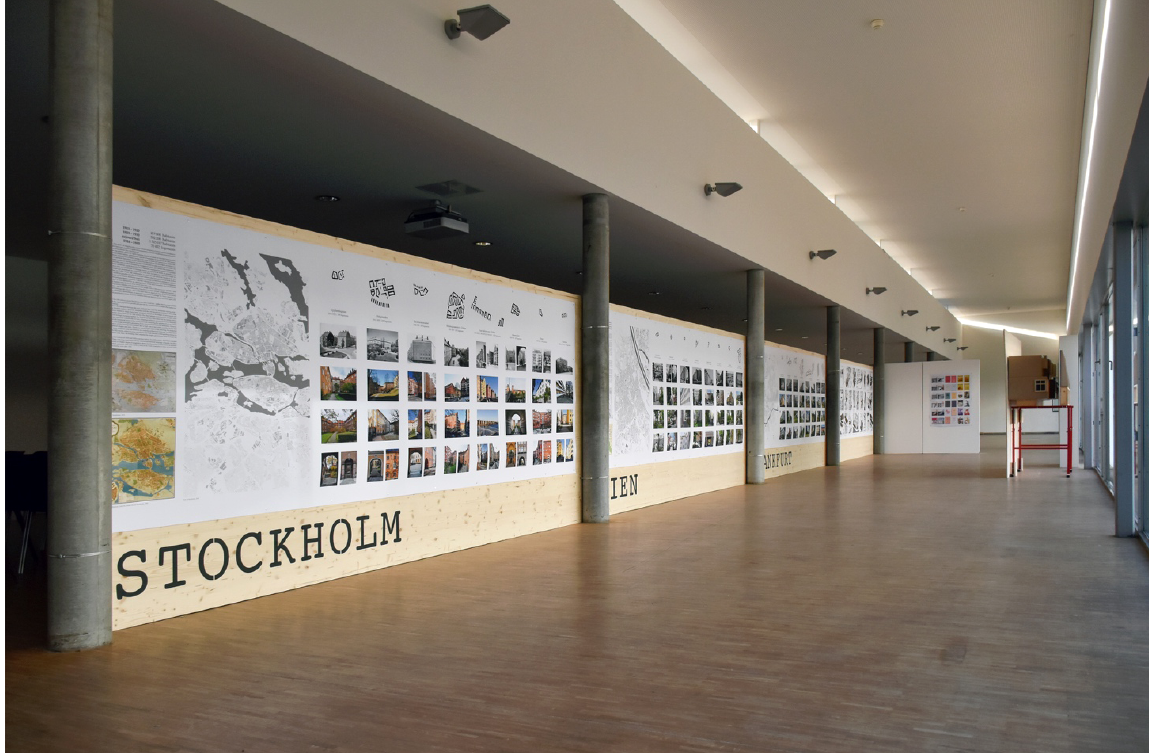
Figure 3. Reverse shot of the main gallery. Source: